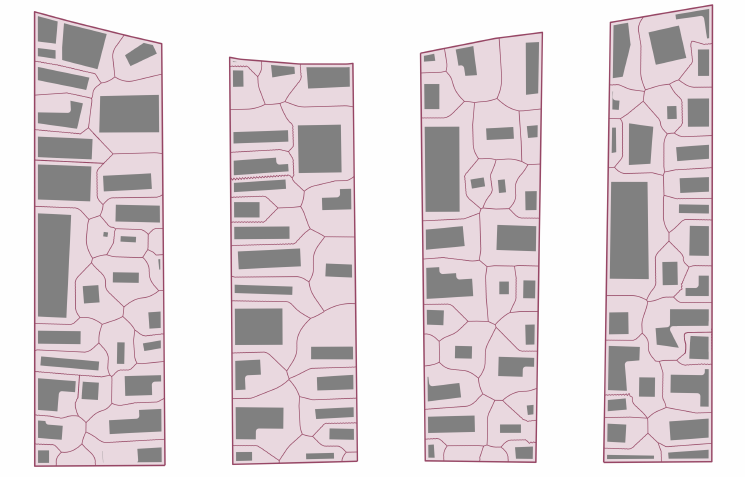
Figure 3. Results of cadastral approximation process. Each light crimson enclosure is a street block from Freetown, with building footprints overlaid in grey, and internal parcel boundaries shown in thinner crimson lines. This illustrative example was programmatically generated with a modified Voronoi